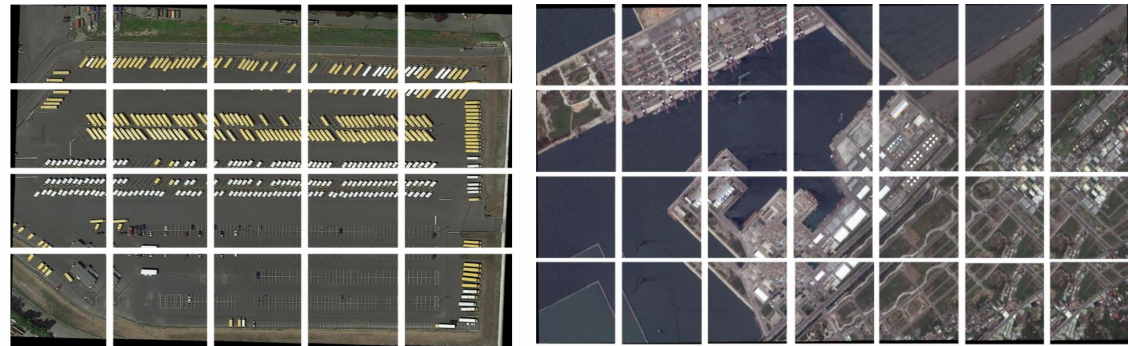
Figure 11. Visualization of the images in the DOTA